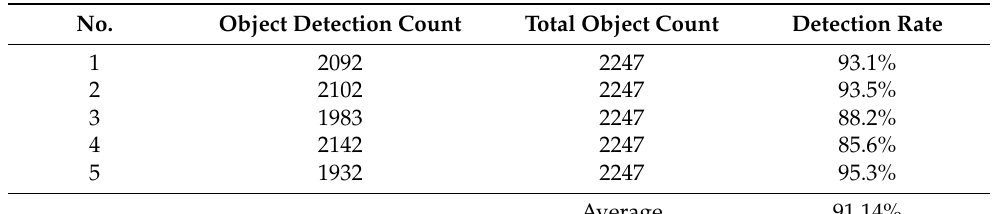
Table 10. Detection rate